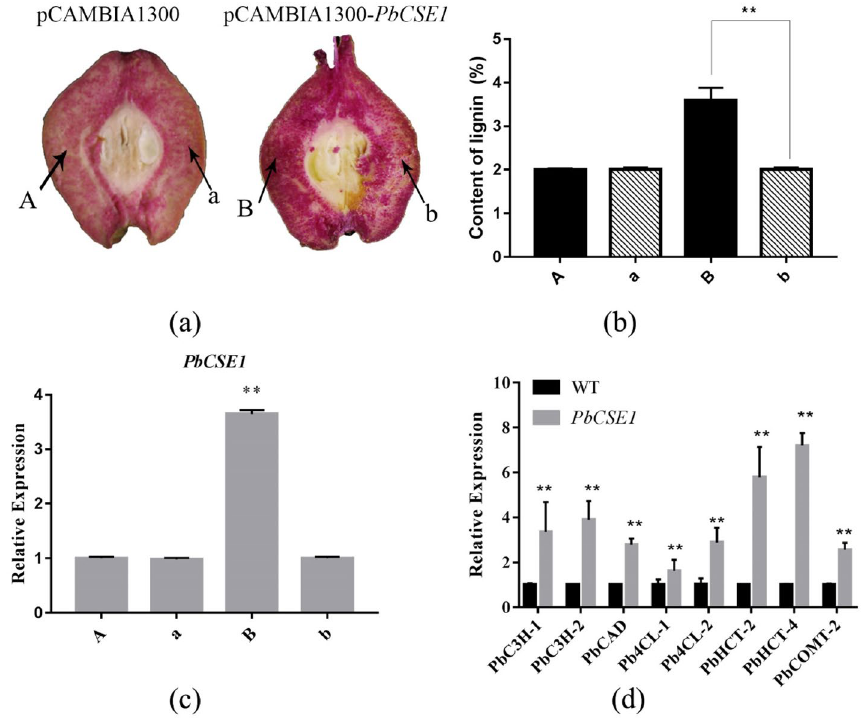
Figure 4. Expression analysis of the CSE -like genes in transgenic pear fruits. ( a ) Transient assays using PbCSEs overexpression in ‘Dangshan Su’ pear at 35 DAB. The infiltration sites were labelled A and B for the different gene constructs and its non-infiltrated sites were labelled a and b. The image was taken 10 d after agro-infiltration. ( b ) The lignin content in the fleshy tissue around the infiltration sites (A and B) and its non- infiltrated sites ( a , b ). ( c ) The expression levels of PbCSE1 in the fleshy tissue around the infiltration sites and their respective non-infiltrated sites using q-PCR analysis. The asterisks indicate values that were determined by the t-test to be significantly different from their equivalent control (** P < 0.01). ( d ) The expression level of lignin synthesis-related genes in the overexpression of PbCSE1 in pear fruits. The genes selected for expression analysis have been previously shown to be highly expressed in the stems where lignified fibers and vessels are abundant 13 . The asterisks indicate values that were determined by the t-test to be significantly different from their equivalent control (** P <